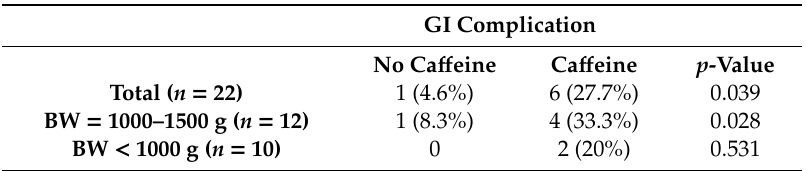
Table 3. Distribution of the presence of any GI complications in the study neonates according to their caffeine intake status and the corresponding p-value.